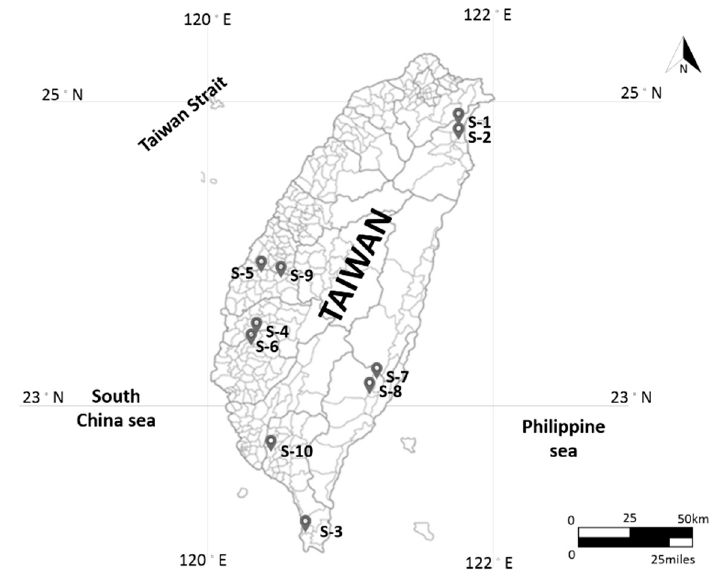
Figure 1. Soil sampling sites of the ten studied paddy fields.